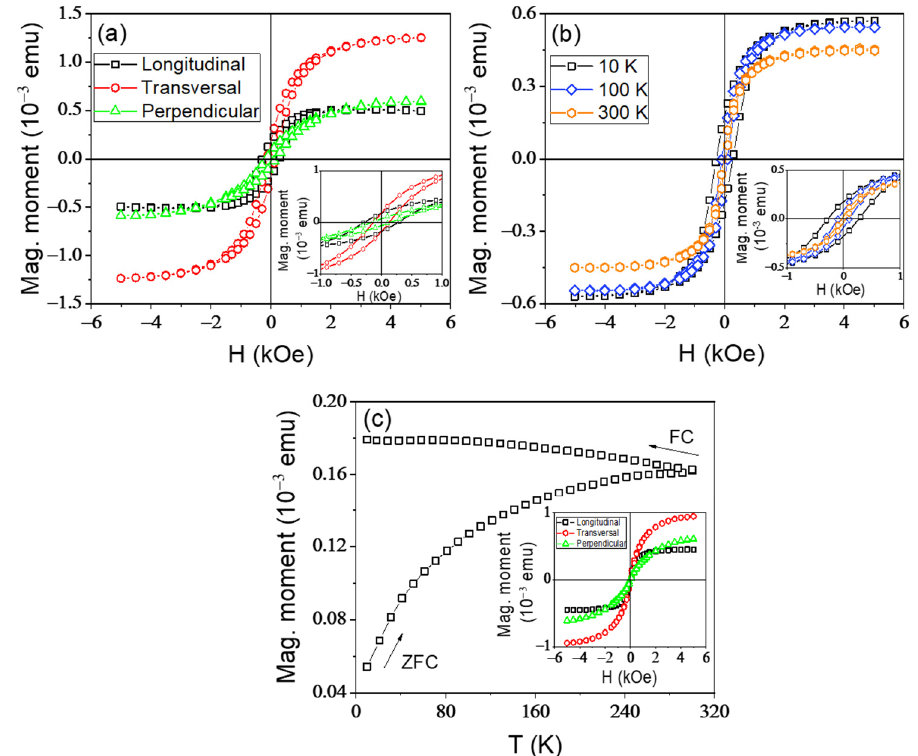
Figure 5. Hysteresis loops of a 3 nm FeCo film grown on more distanced trenches, collected at 10 K in longitudinal, transversal, and perpendicular geometry ( a ); hysteresis loops as a function of temperature in longitudinal geometry ( b ). Insets present an enlarged image of the hysteresis loops around the origin; ZFC-FC curve in longitudinal geometry. Inset shows the hysteresis loops collected at 300 K in different geometries ( c